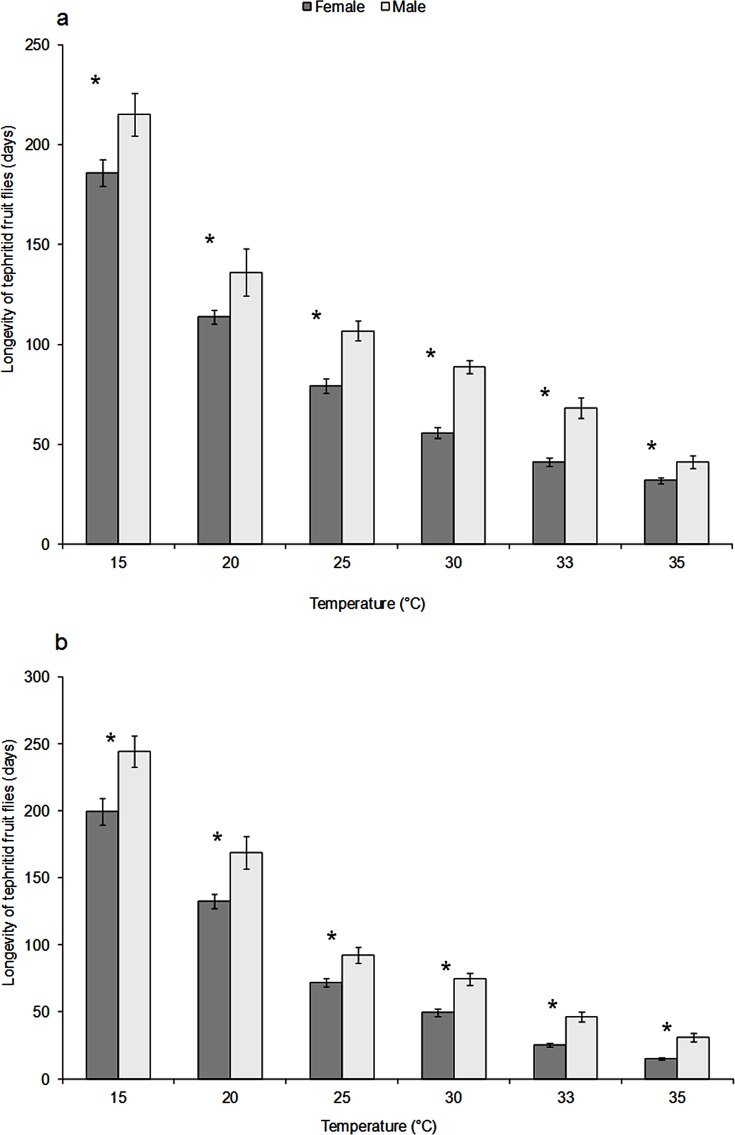
Mean longevity of females and males of C. rosa (3a) and C. quilicii (3b) at different temperature regimes. Asterisks above bars denote statistically significant differences comparing the sexes for each tested temperature category. Error bars represent the standard error generated from 15 replicates per condition.